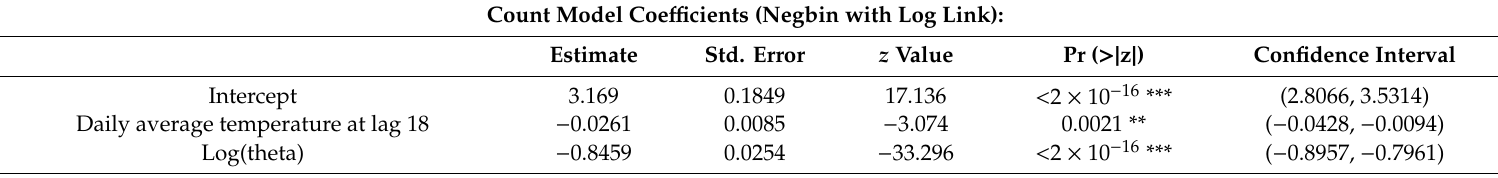
Table 1. Estimates of zero-inflated negative binomial regression model for Mopani district